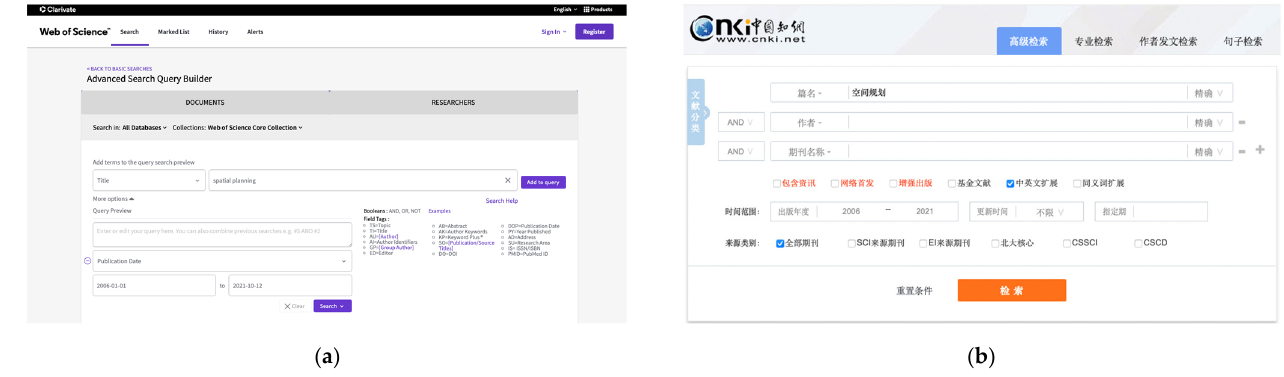
Figure 1. Advanced search pages for WOSCC ( a ) and CNKI database ( b ).